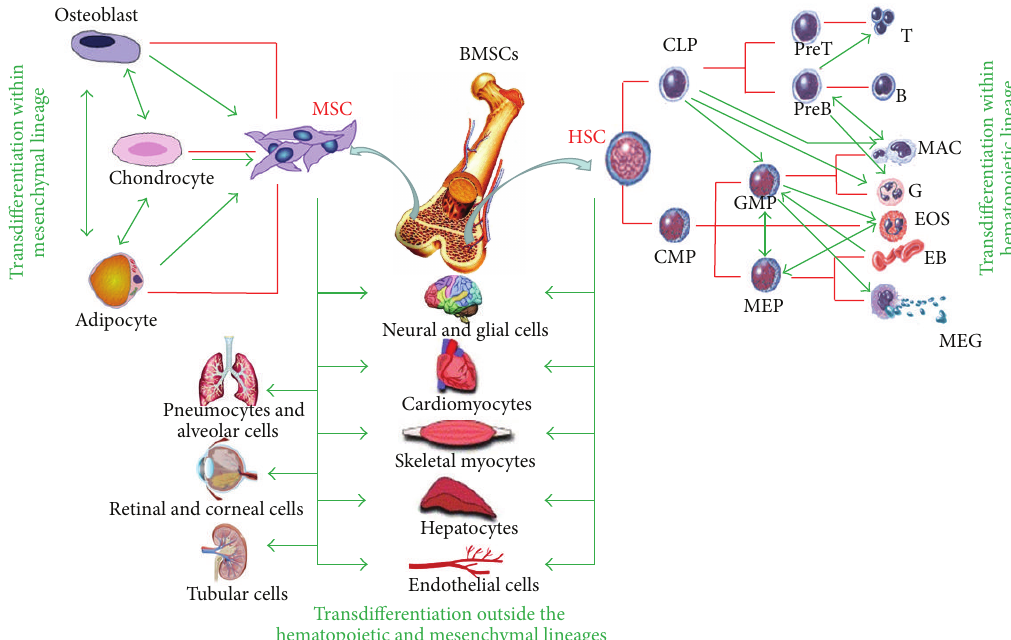
Figure 1: Plasticity of BM HSC and